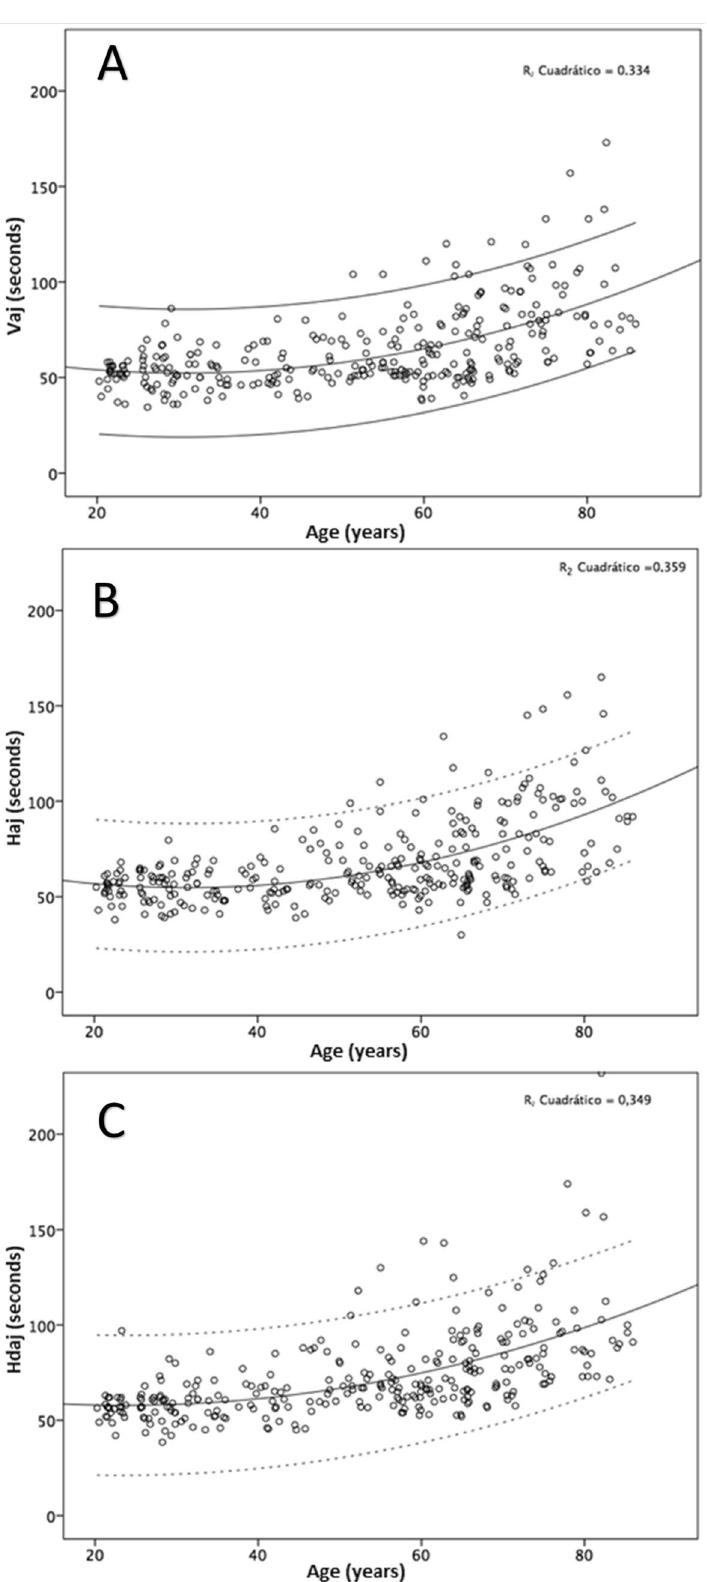
Figure 4. Scatterplot showing the correlation between the age of participants and the ADEMd outcomes: vertical adjusted time ( A ), horizontal adjusted time ( B ), and horizontal distractor adjusted time ( C ). A curvilinear trend, represented by the solid line, is observed in the results of all the sheets. Confidence intervals at 95% are pictured by the dotted lines. Haj horizontal adjusted time, Hdaj horizontal distractor adjusted time, IC confidence interval, Vaj vertical adjusted